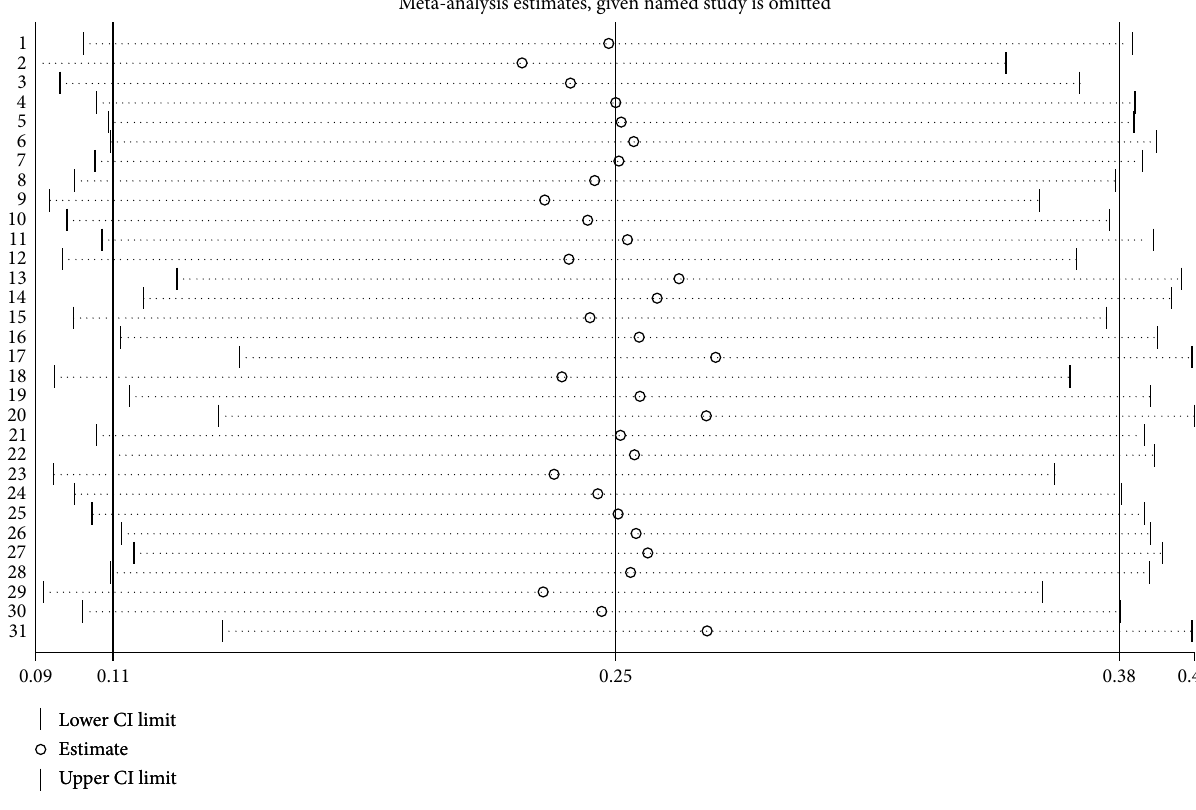
F IGURE 7: Results of the in fl uence analysis.